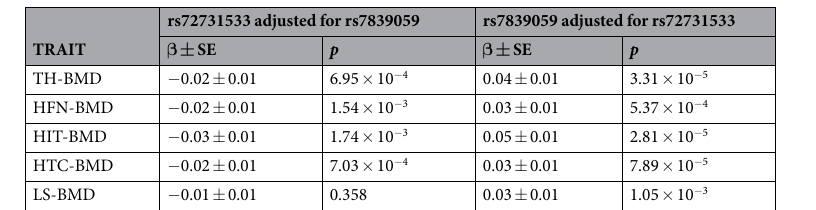
Table 5. Conditional association analysis using rs7839059 and rs72731533. TH-BMD: total hip BMD; HFN- BMD: hip femoral neck BMD; HIT-BMD: hip intertrochanter BMD; HTC-BMD: hip trochanter BMD; LS- BMD: lumbar spine BMD; β : estimates of effect size expressed as adjusted SD per copy of the effect allele; SE: standard error of β ; p : p-value in the conditional